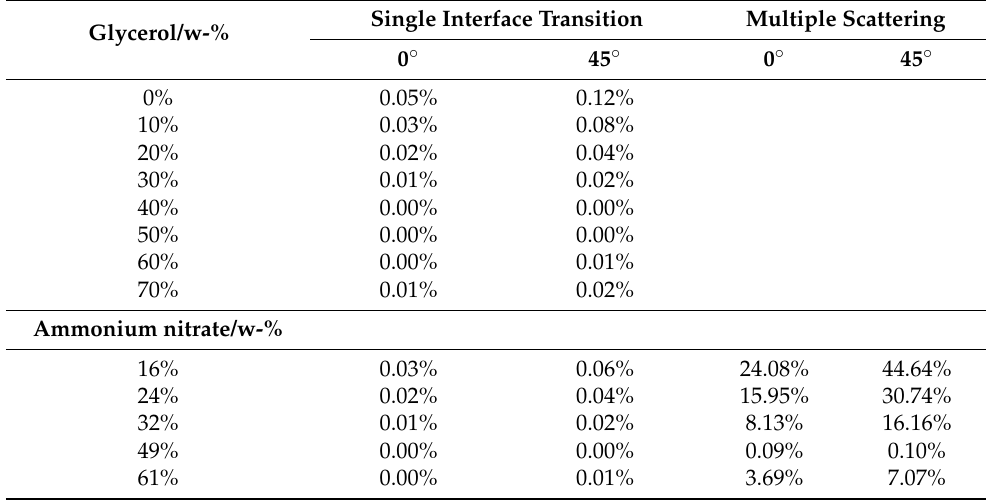
Table 3. Reflectance between the water phases and the oil phase. For the inner phases, the reflectance for multiple scattering of 1000 phase transitions is calculated. Single Interface Transition Multiple Glycerol/w-%